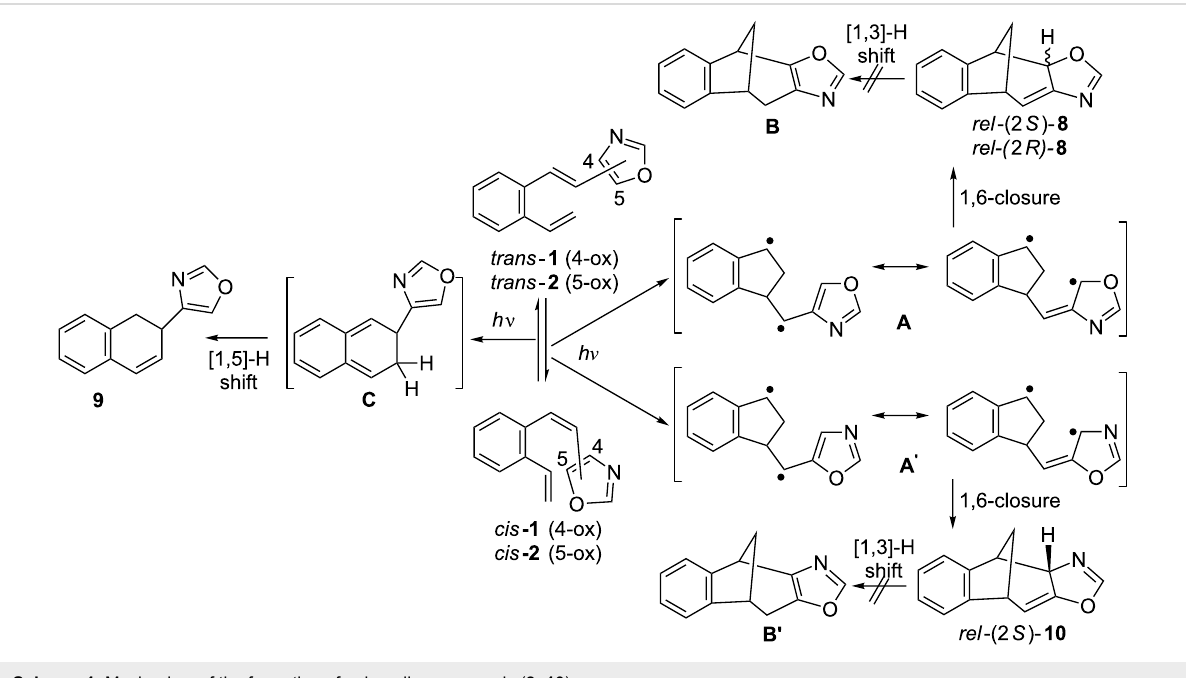
Scheme 4: Mechanism of the formation of polycyclic compounds ( 8 – 10